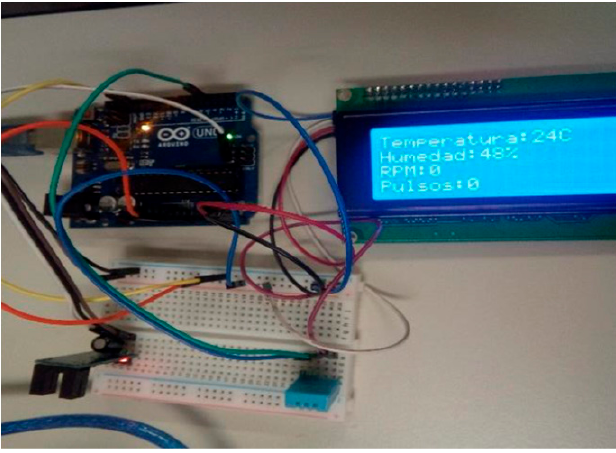
Figure 14. Sensor and LCD display testing.